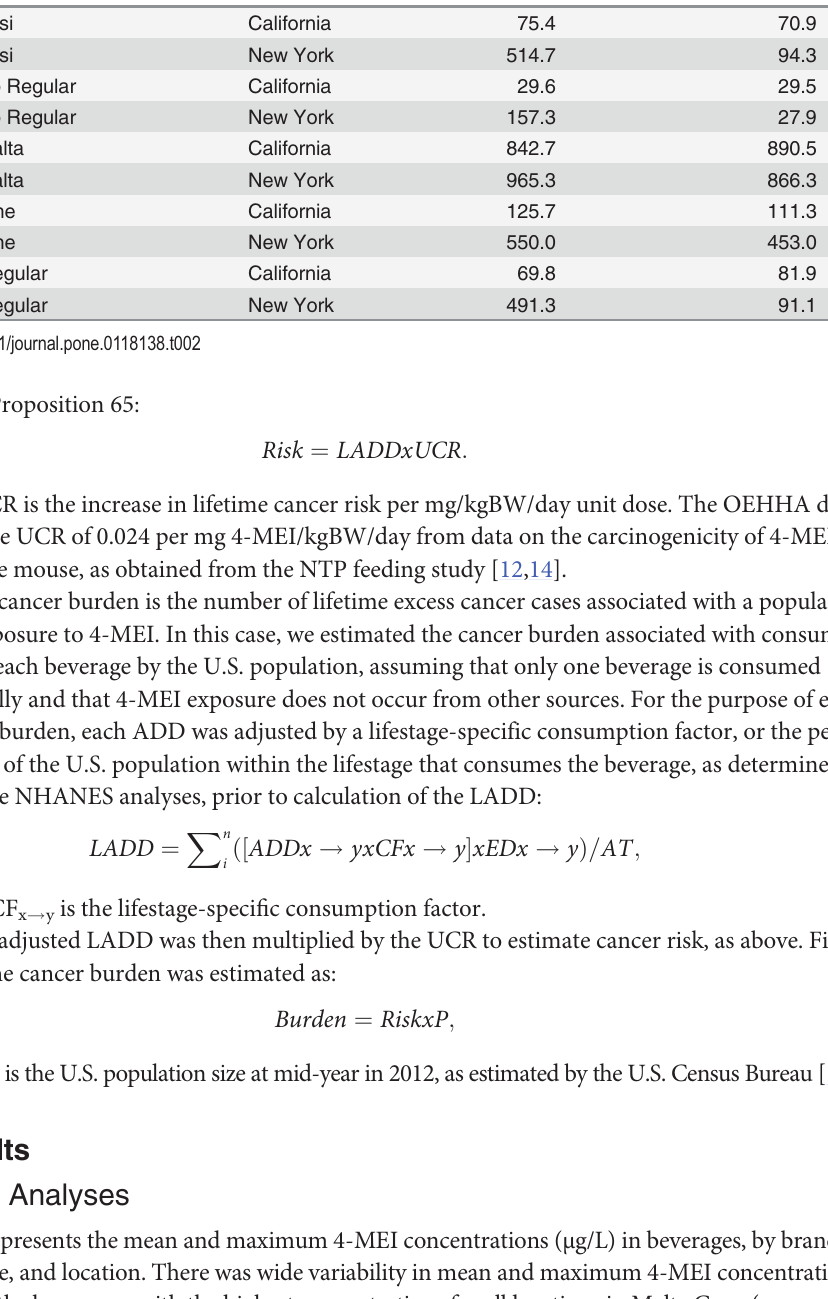
Table 2. Mean 4-MEI concentrations in beverages (in μ g/L), by purchase location and 2013 month of sampling.